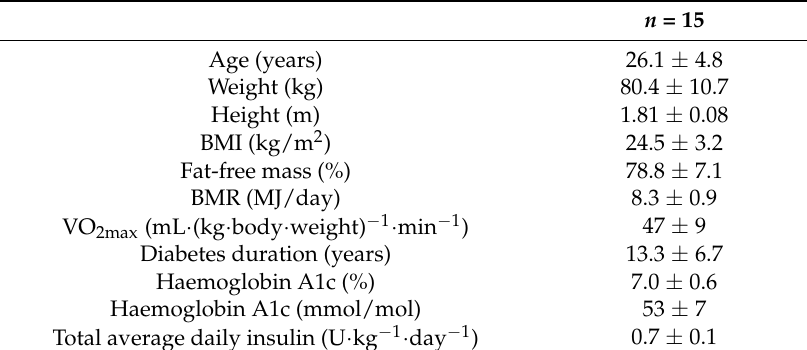
Table 1. Baseline characteristics. Data presented as mean (SD).